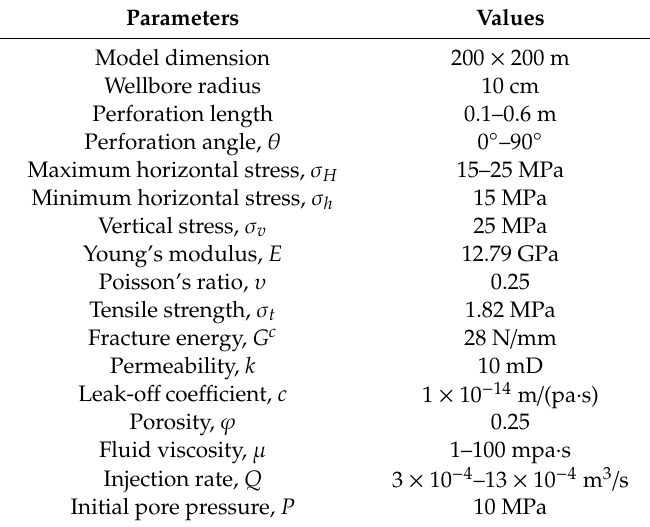
Figure 4. Model construction: ( a ) construction of initial fracture and perforation; and ( b ) mesh part of whole model. Table 1. Input parameters of the numerical model.